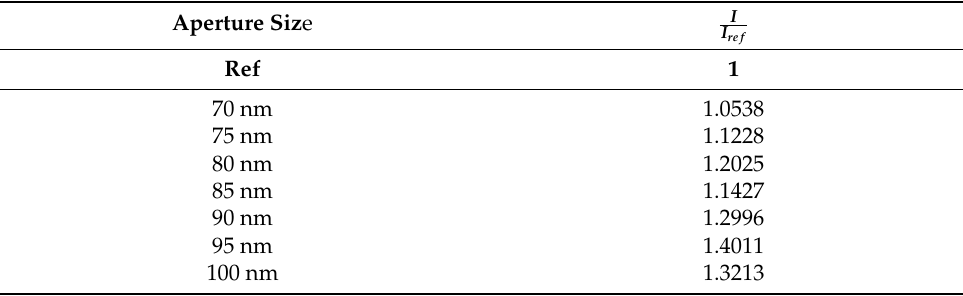
Table 2. Periodicity sweep at 1 µm with terminal current ratio.